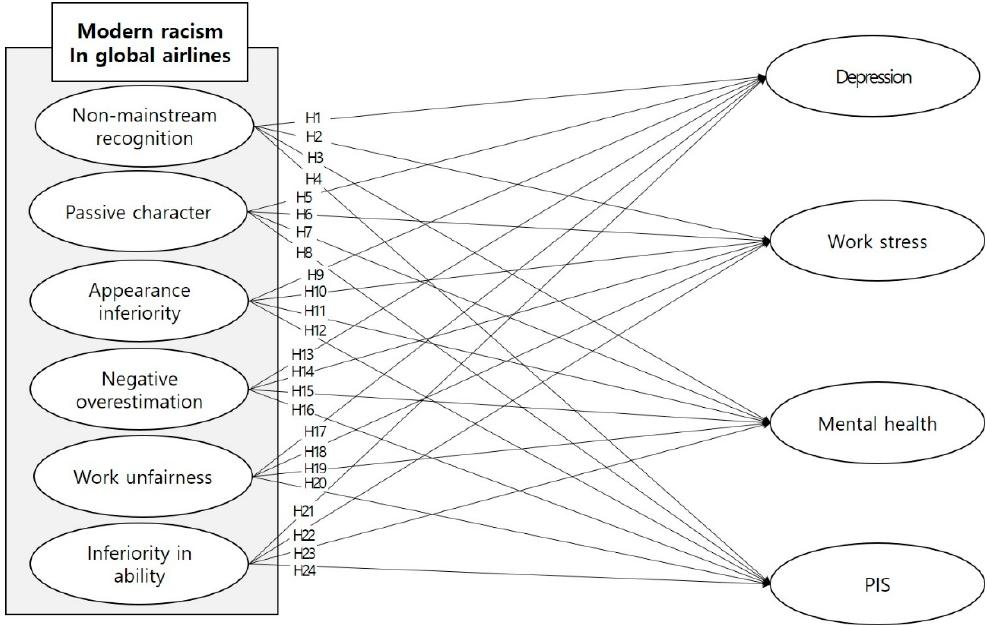
Figure 1. The research model of modern racism.